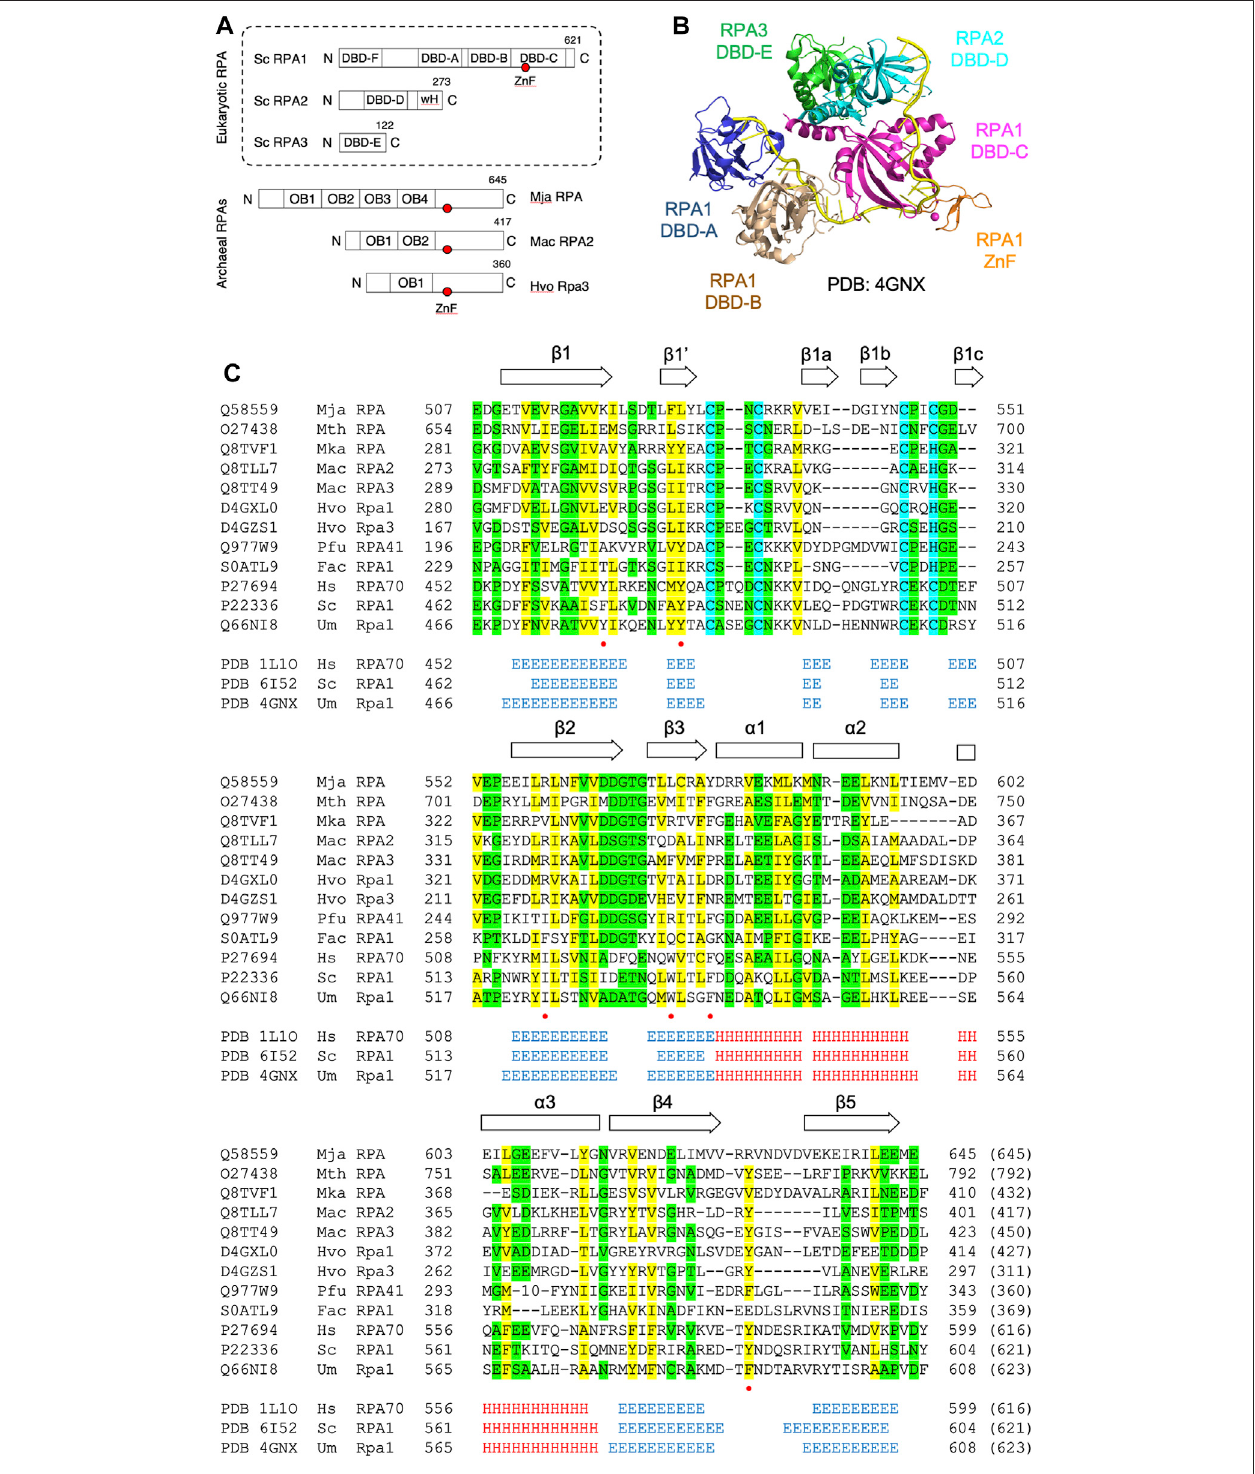
FIGURE 1 | DBD-C-like OB fold in the archaeal RPA1-like proteins (A) Domain structure of eukaryotic and archaeal RPA proteins: S. cerevisiae RPA complex components RPA1, RPA2, and RPA3 (boxed with OB folds labelled DBD-A through-F) and representative archaeal zinc fi nger-containing RPA proteins from Methanocaldococcus jannaschii (MjaRPA), Methanosarcina acetivorans (MacRPA2), and Haloferax volcanii (HvoRpa3). The location of zinc fi nger (ZnF) and RPA2 wingedhelix (wH) domains areindicated (B) Crystalstructure ofthetrimerization coreof Ustilagomaydis RPAbound tosingle-stranded DNA(PDB 4GNX) withOB